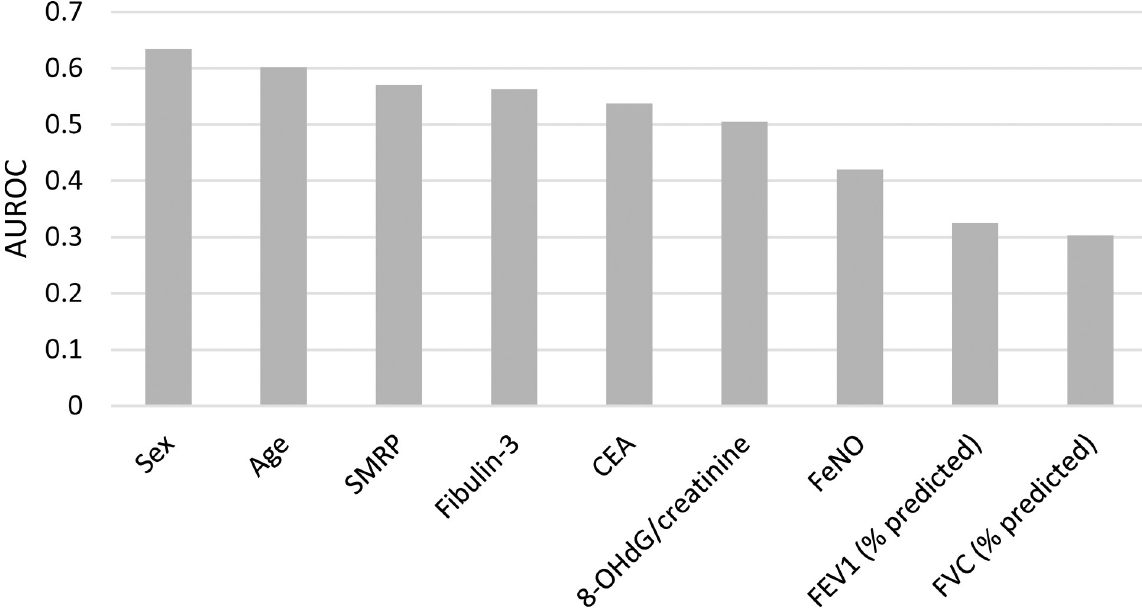
Fig 2. The AUROC for pneumoconiosis. The AUROCs of sex, age, SMRP, fibulin-3, CEA, and 8-OHdG/creatinine were greater than 0.5, suggesting that their predictive capacities perform better than random. A single breath test for FeNO, FEV1, or FVC cannot predict